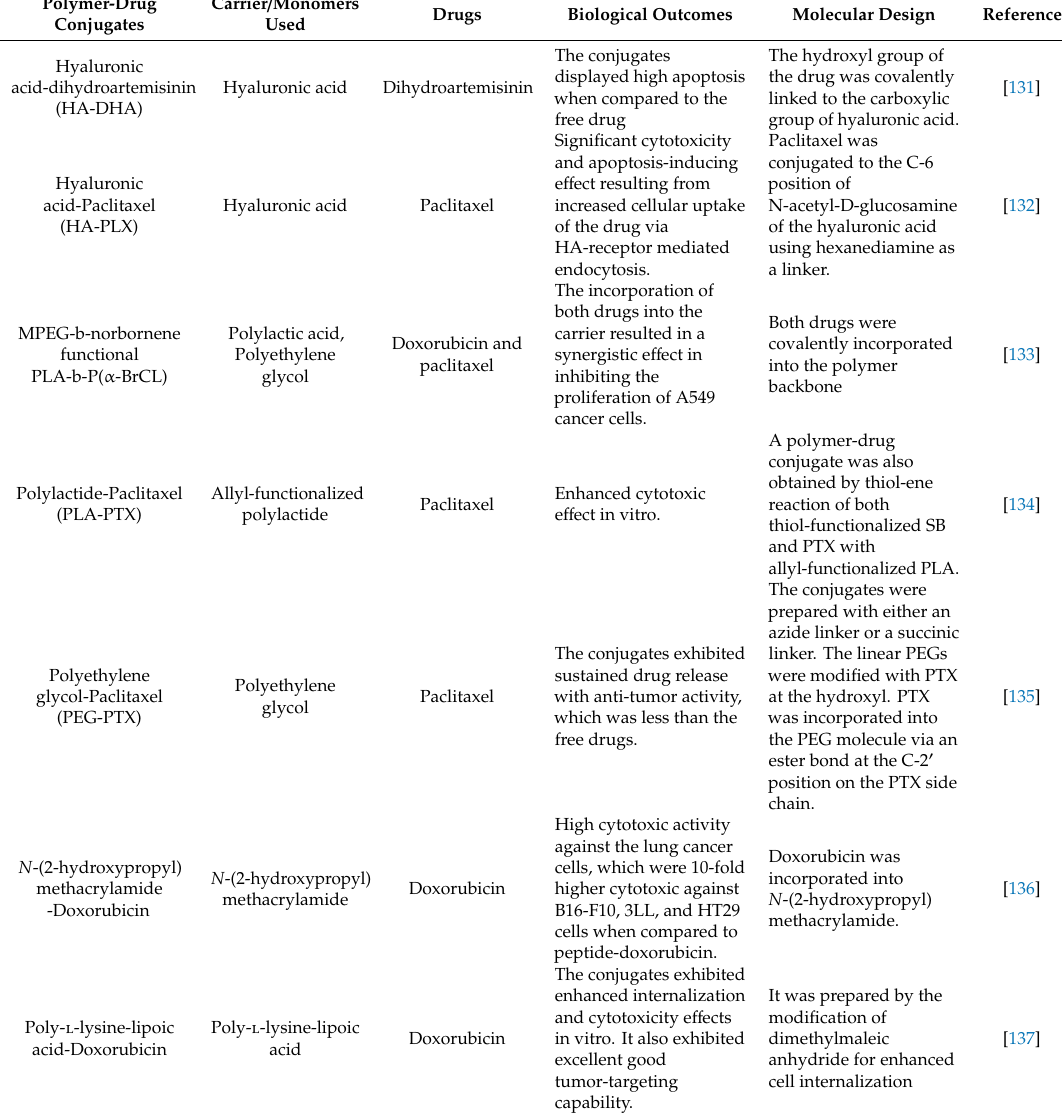
Table 3. Summary of polymer-drug conjugates, which are e ff ective in vitro and in vivo against lung